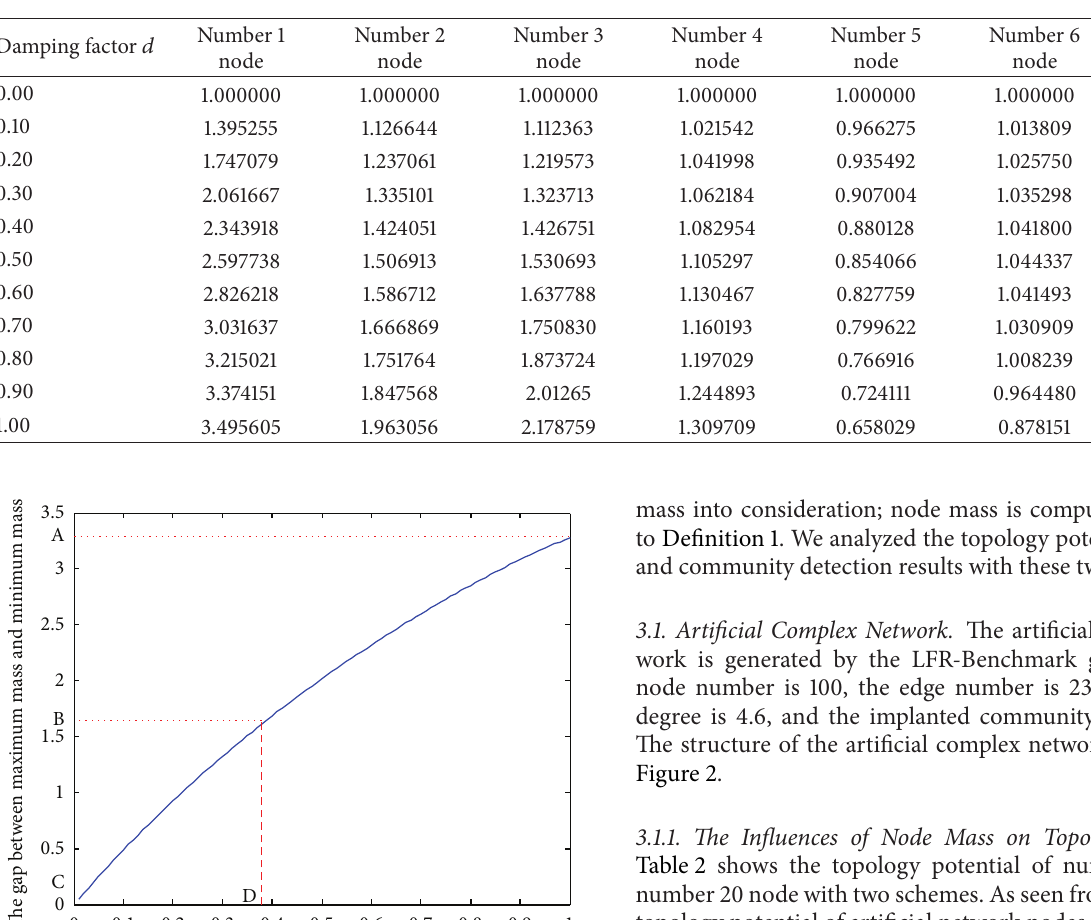
Table 1: The relationship between damping factor 𝑑 and node mass.